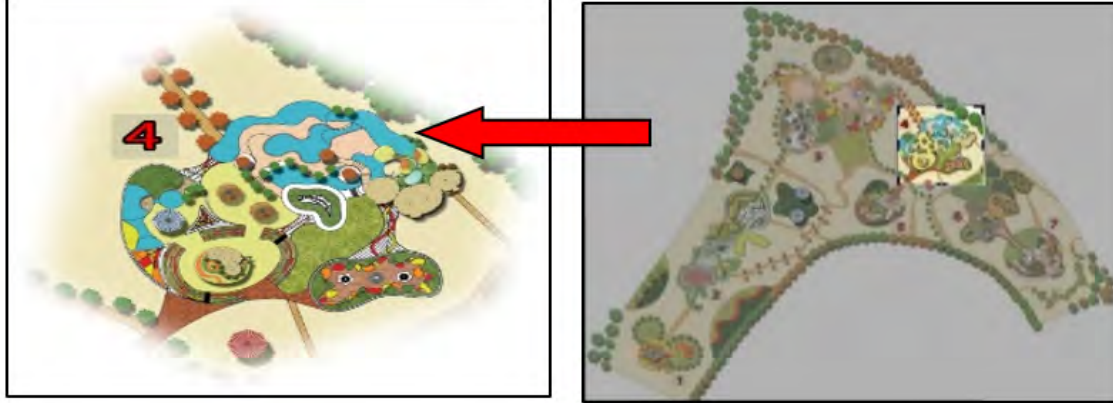
Figure 18. The location of “water world”